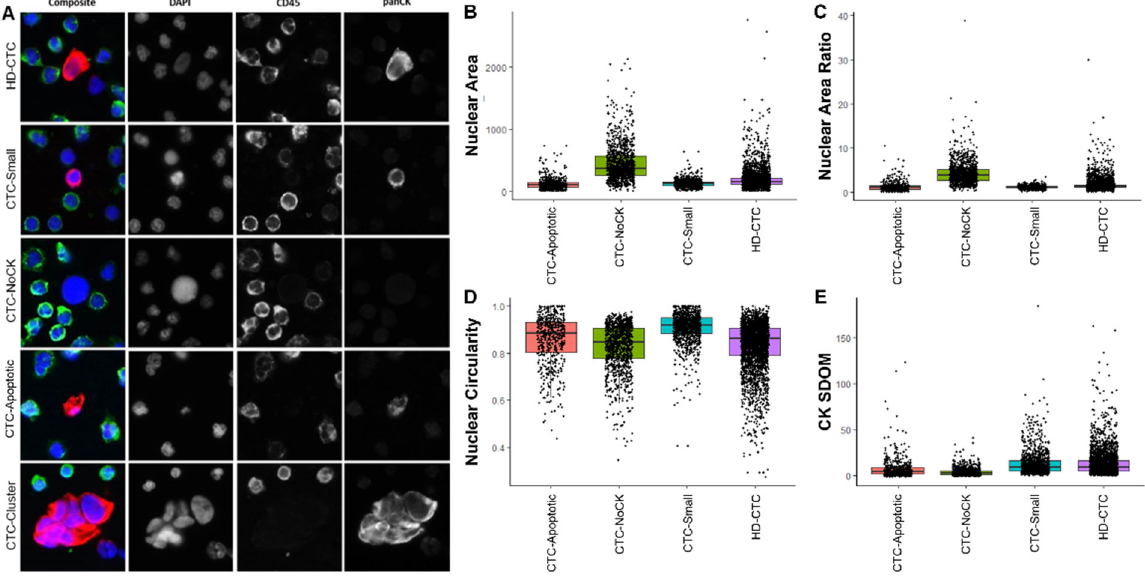
Figure 1. CTCs detected by HDSCA in mCRC patient samples. ( A ) Representative images of CTCs taken at 400×. Red: CK, Green: CD45, Blue: DAPI. ( B – E ) Morphometric analysis of CTCs by subtype. CTC ‐ positivity was defined as the presence of ≥ 1 CTC/mL detected in the liquid bi ‐ opsy sample. CTC enumeration over time is represented graphically in Figure 2. At 1–2 weeks prior to surgical resection, 7 of 10 patients were HD ‐ CTC positive, with a median of 7.02 (mean 93.48 ± 226.77) HD ‐ CTCs/mL. At the pre ‐ resection time ‐ point on the day of surgery in which a majority of patients provided a blood draw, 30 of 45 patients were HD ‐ CTC positive, with a median of 6.61 (mean 86.82 ± 196.96) HD ‐ CTC/mL. Immediately fol ‐ lowing resection, 32 of 41 patients were HD ‐ CTC positive, with a median of 4.81 (mean 37.95 ± 78.35) HD ‐ CTC/mL. HD ‐ CTC positivity at subsequent time ‐ points following re ‐ section were as follows: 8 of 12 patients at 2 days, 18 of 27 patients at 1–2 weeks, 4 of 6 patients at 1 month, 5 of 6 patients at 2–3 months, 8 of 10 patients at 6 months, and 2 of 2 patients at 1 and 2 years.